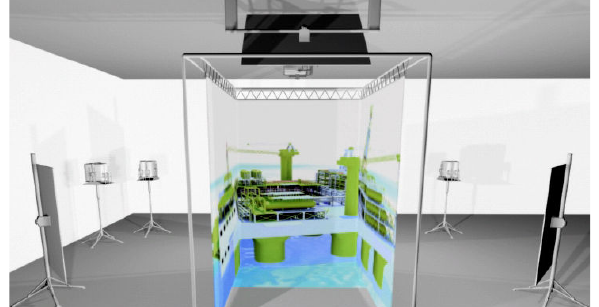
Figure 8. 3D model of the CAVE at LNCC